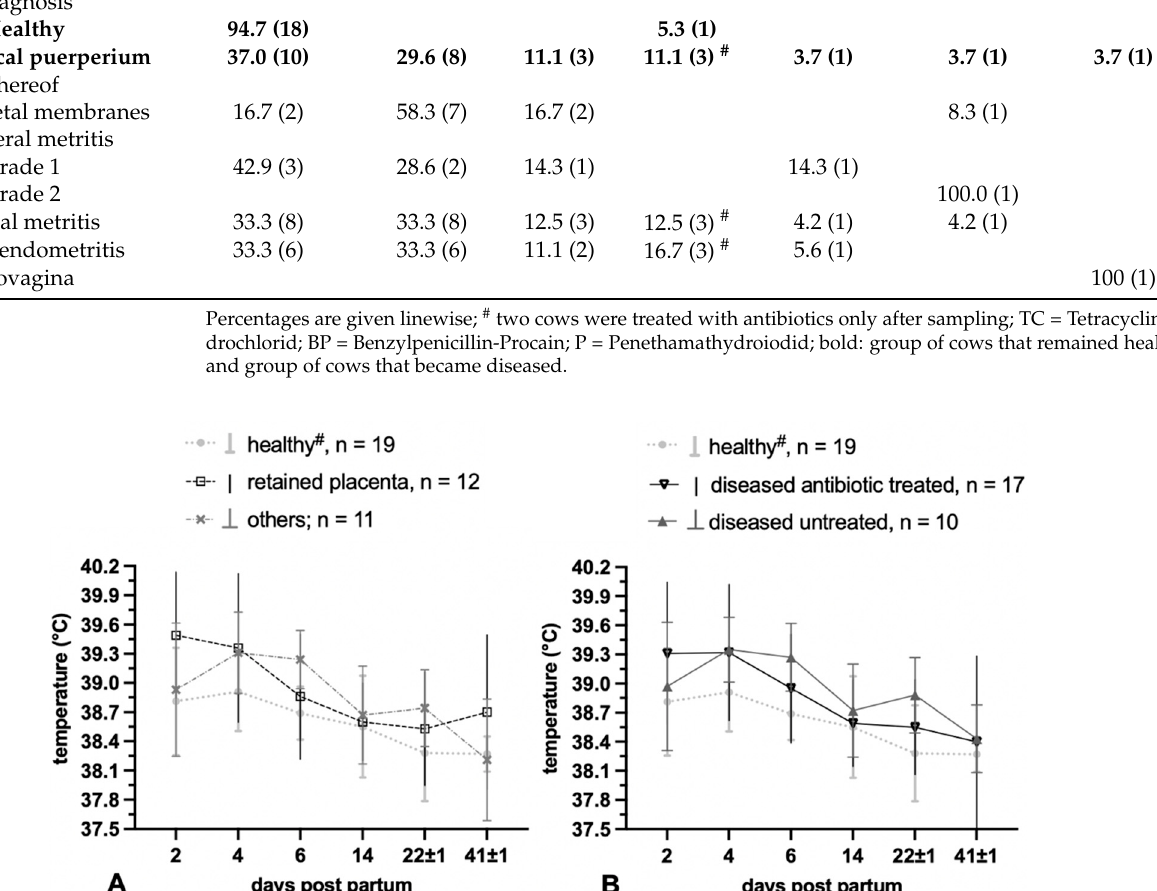
Figure 2. Mean values and standard deviation of rectal body temperature over the period of puer- perium in cattle that remained healthy (grey dotted); ( A ) additionally specific disease patterns; ( B ) additionally diseased cows treated with antibiotic treatment and without treatment. Others: cows showing a pathological puerperium but no singular postpartum retention of the fetal membranes or all forms of puerperal disorders; # one healthy cow showed fever due to a different diagnosis.